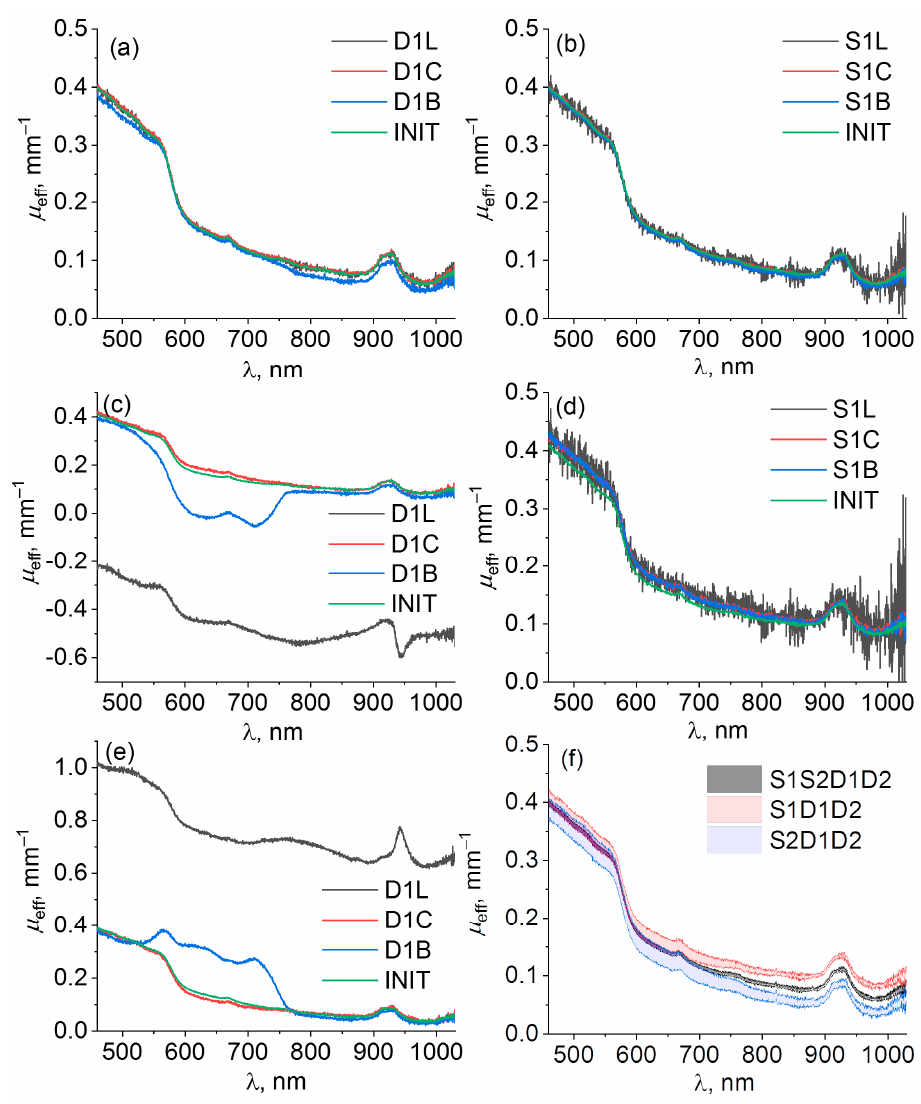
Figure 3. Spectra of µ P , m of a biotissue phantom calculated with self-calibrating approach S1S2D1D2 ( a , b ) and single-slope approach in configurations S1D1D2 ( c , d ) and S2D1D2 ( e ) for different kinds of detector (left column) and source (right column) perturbations listed in Table 1. Index m indicates individual measurement under particular perturbation P. Comparison of µ INIT spectra ( f ) obtained by three approaches S1S2D1D2 (gray), S1D1D2 (red), and S2D1D2 (blue) for unperturbed measurements shown as mean with confidence bounds.